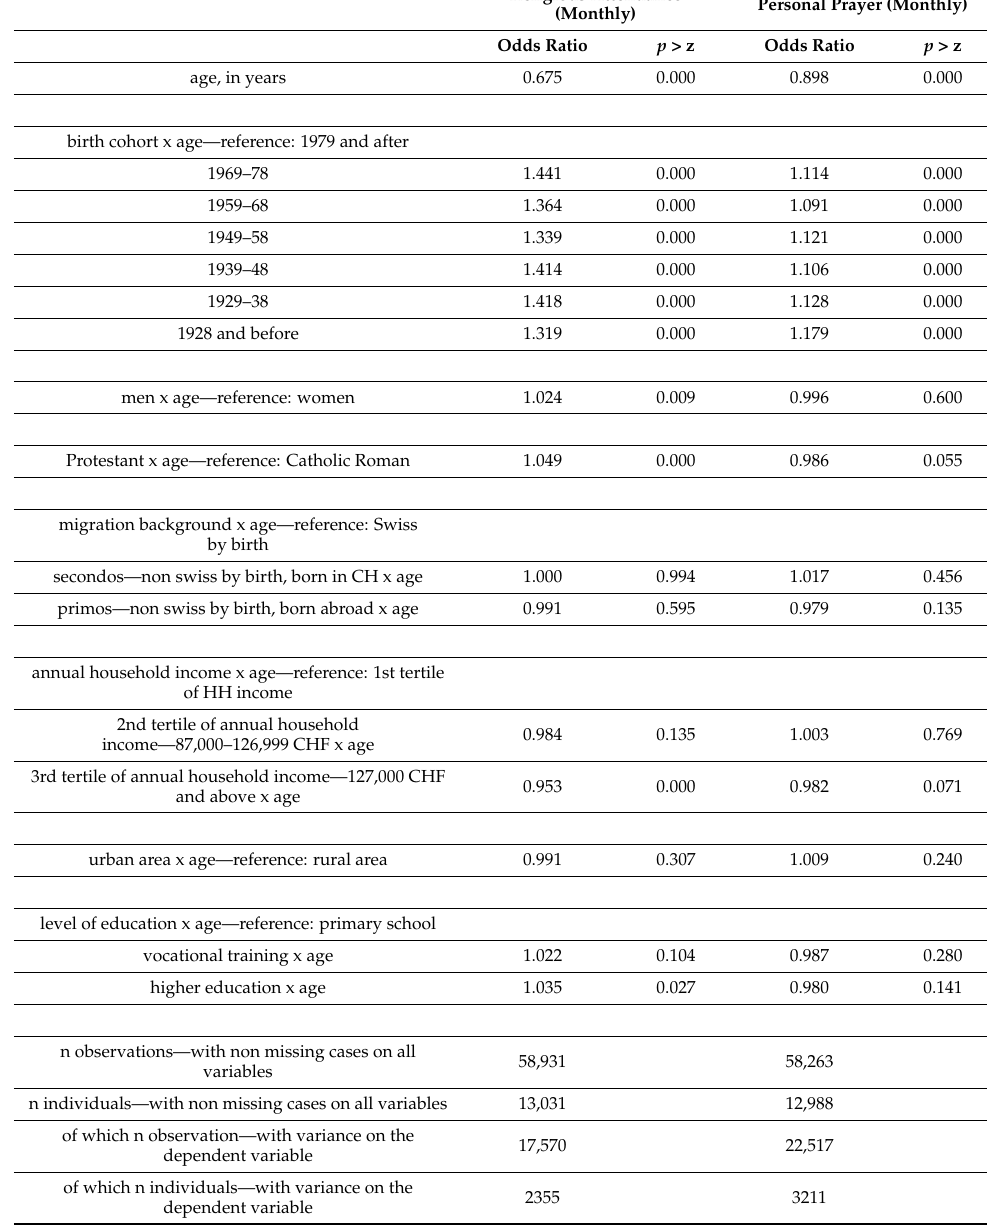
Table 5. Religious attendance and personal prayer—fixed effects logistic regression